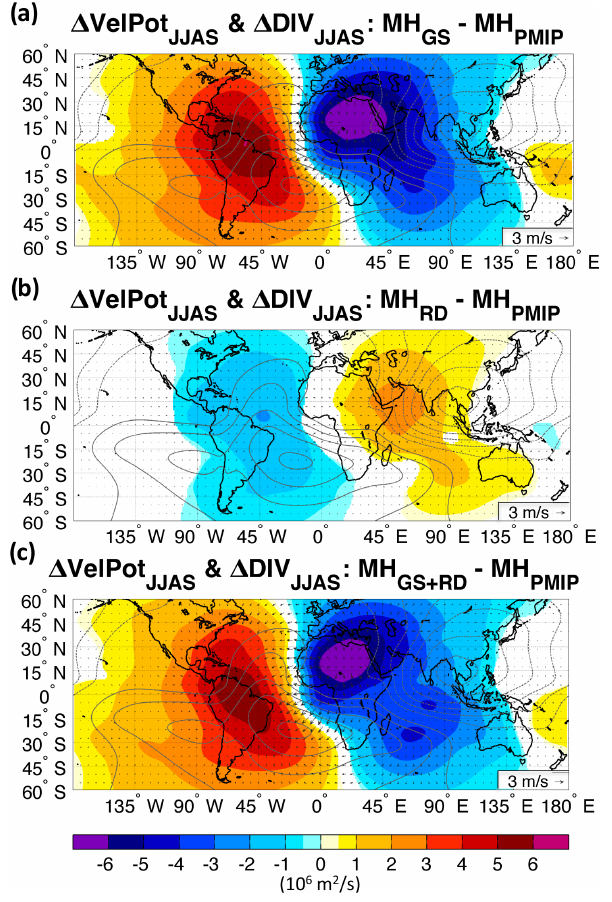
Figure A13. Changes in summer (JJAS) velocity potential (VelPot – shadings; m 2 /s) and divergence wind (DIV – arrows; m/s) at 200hPa for (a) the Sahara greening (MH GS ); (b) the dust-only re- duction (MH RD ); and (c) the Sahara greening and dust reduction (MH GS + RD ) experiments relative to the mid-Holocene-only orbital forcing (MH PMIP ). The contour lines show the climatological sum- mer velocity potential of the MH PMIP experiment. Only differences significant at the 95% confidence level using the Student t test are shaded.